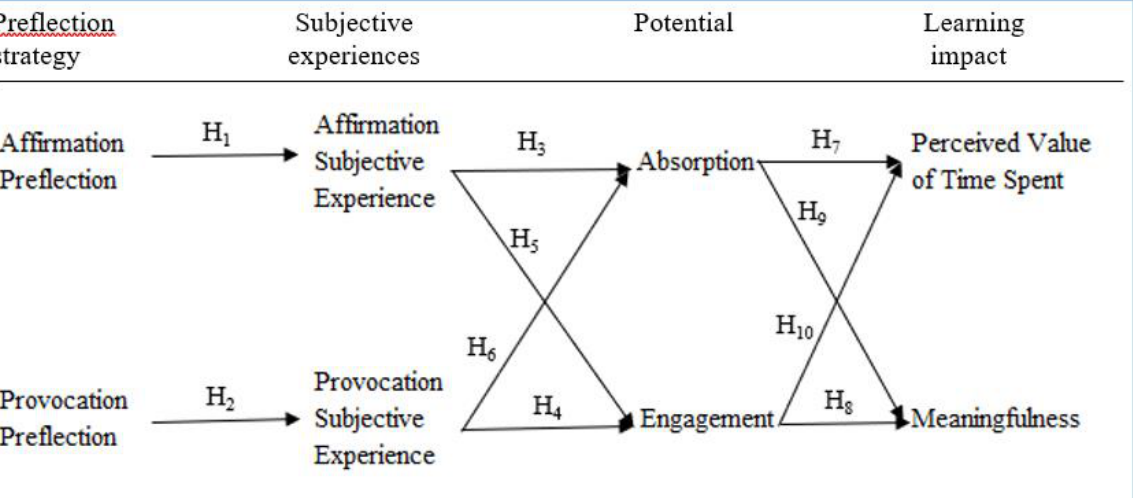
Figure 1. Presumed Relations Among Preflection, Subjective Experiences, and Learning Impact